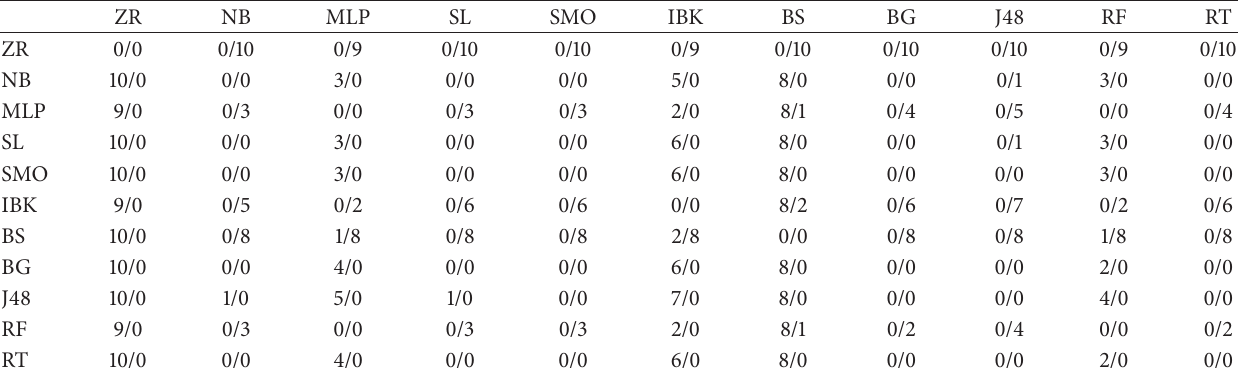
Table 8: Pairwise comparison of accuracies (win/loss over 11 datasets) of all algorithms using 10 cv 𝑡 -Test.